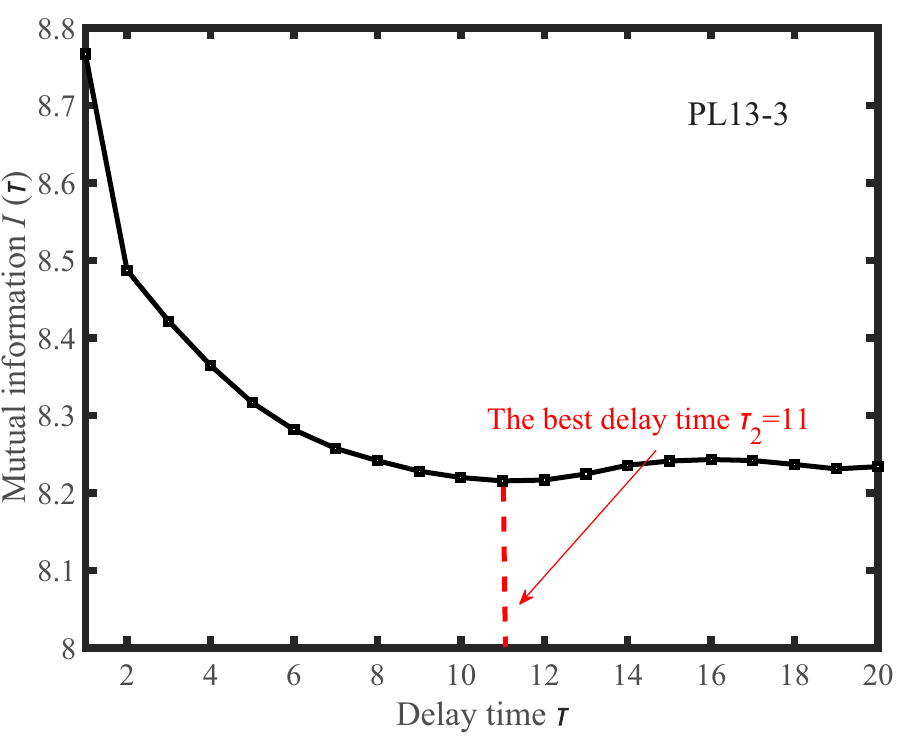
Fig 30. I ( τ ) ~ τ curve for the observed displacement data series of the PL13-3.